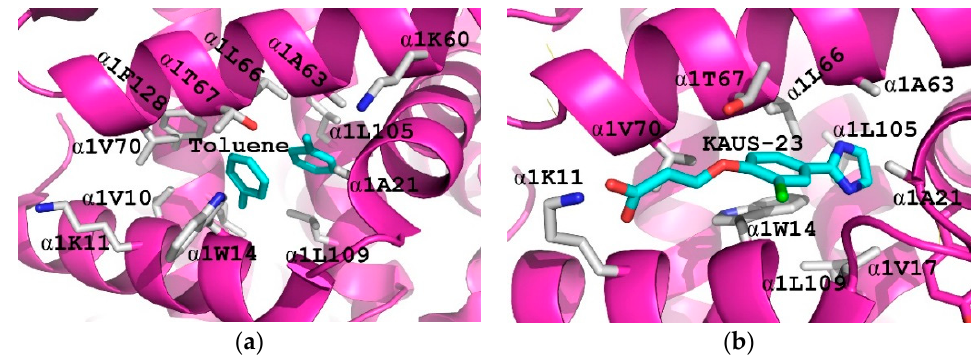
Figure 2. The α Trp14 binding pocket. ( a ) Binding of two molecules of toluene at the α Trp14 binding pocket of carbonmonoxy Hb (PDB ID: 1R1X). As noted in the text, CFA binds in a similar fashion but the coordinate is not available [27]; ( b ) Putative binding of KAUS-23 at the Trp14 binding pocket of deoxygenated Hb (PDB ID: 2DN2).